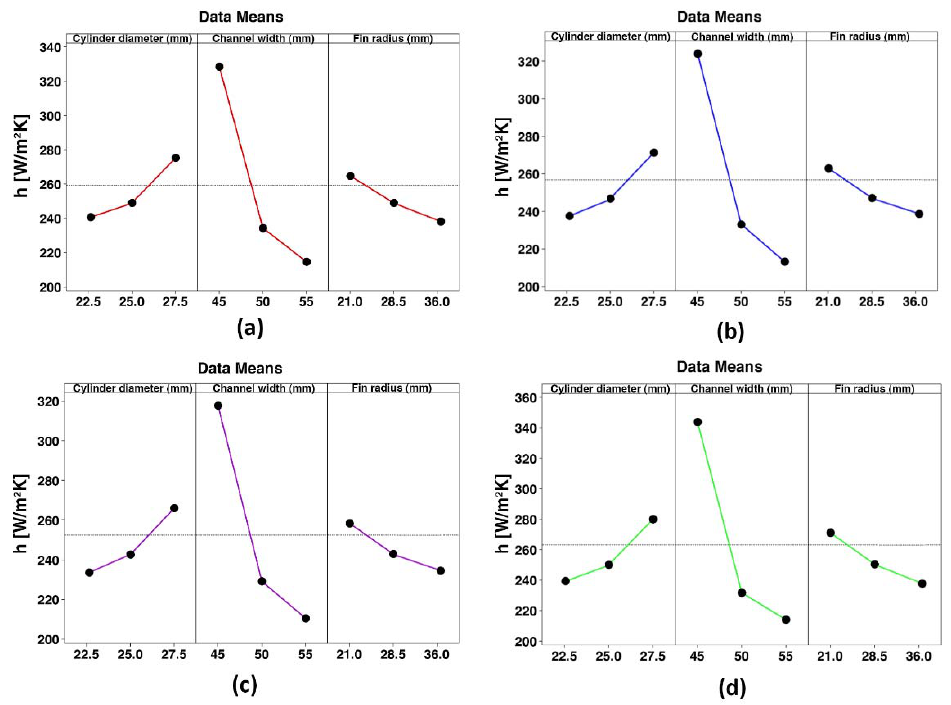
Figure 10. Main e ff ects plots for the HTC. ( a ): ϕ = 0%, ( b ): ϕ = 1%, ( c ): ϕ = 3%, and ( d ): ϕ = Figure 10. Main effects plots for the HTC. ( a ): φ = 0%, ( b ): φ = 1%, ( c ): φ = 3%, and ( d ): φ = 5%.